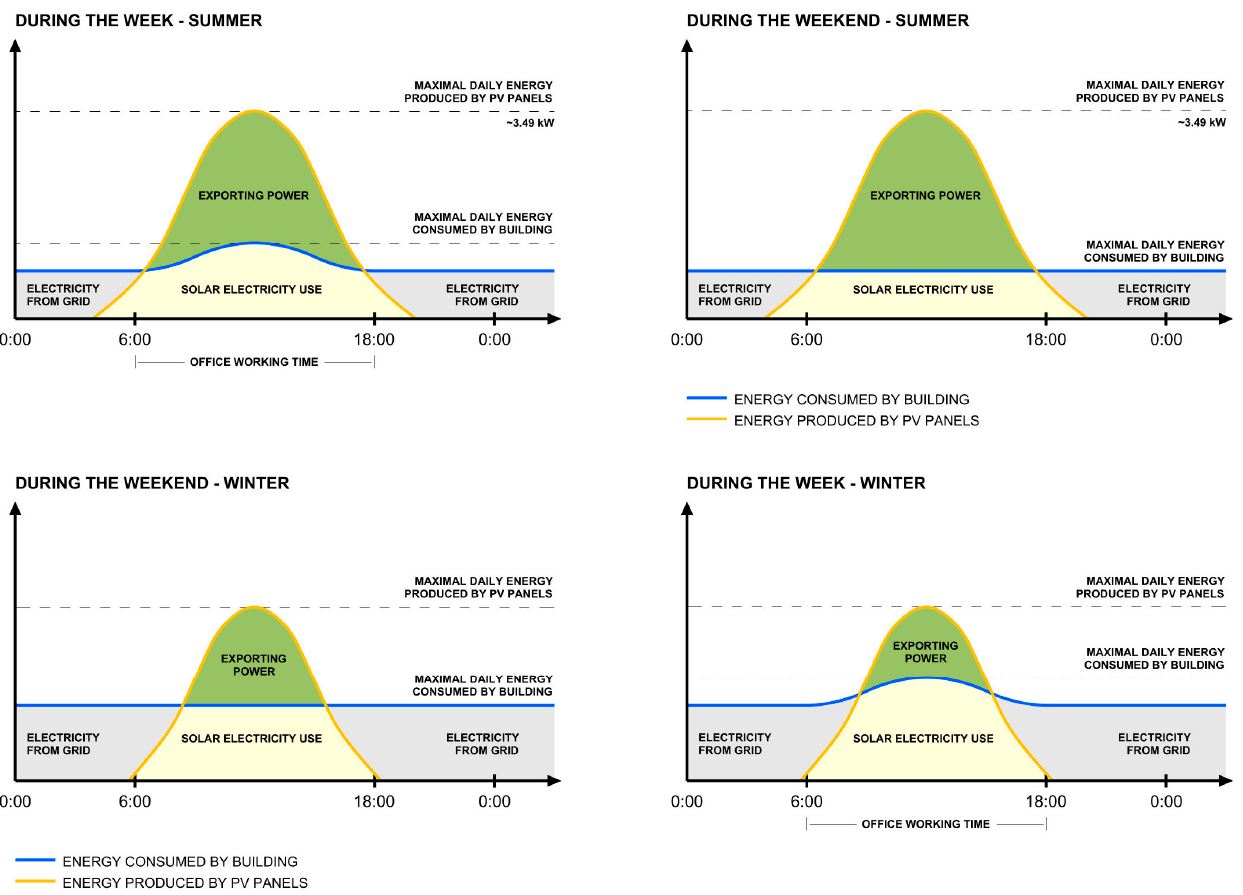
Figure 16. Potential of power transfer with regard to average values of energy consumption and production by RES in the analysed building.